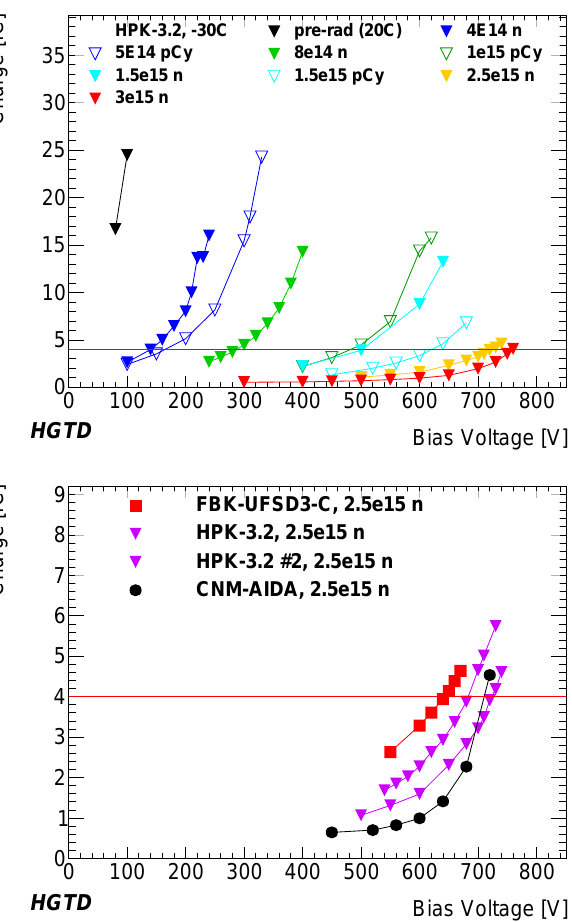
Fig. 7: Collected charge as a function of bias voltage for different fluences for HPK-3.2 (top) and at maximum fluence for all vendors (bottom)